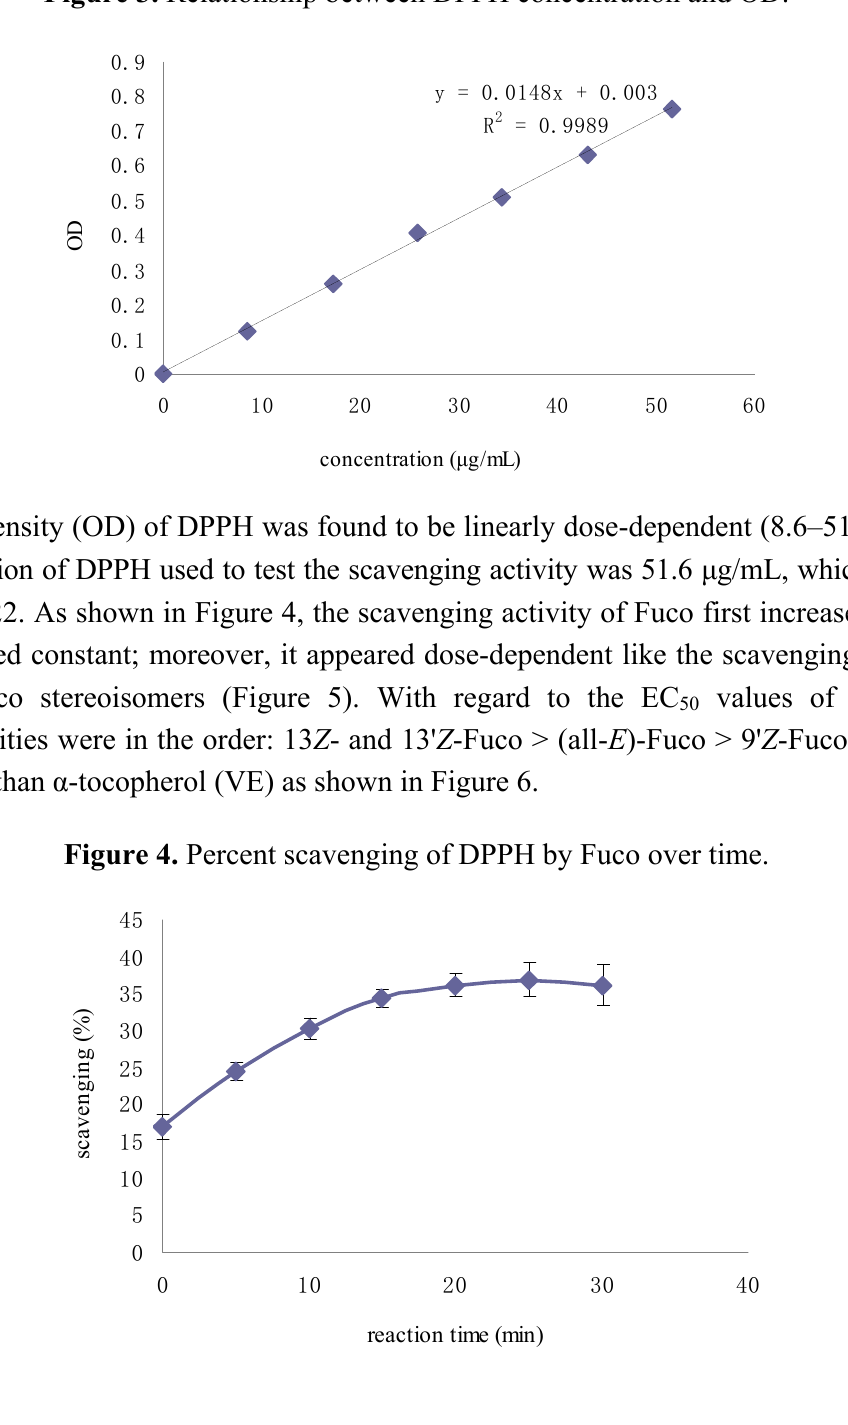
Figure 3. Relationship between DPPH concentration and OD.